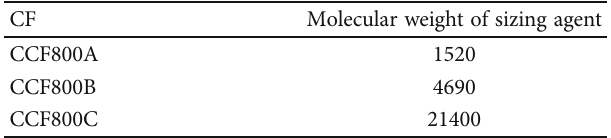
Table 1: The nominal sizing agent molecular weight.